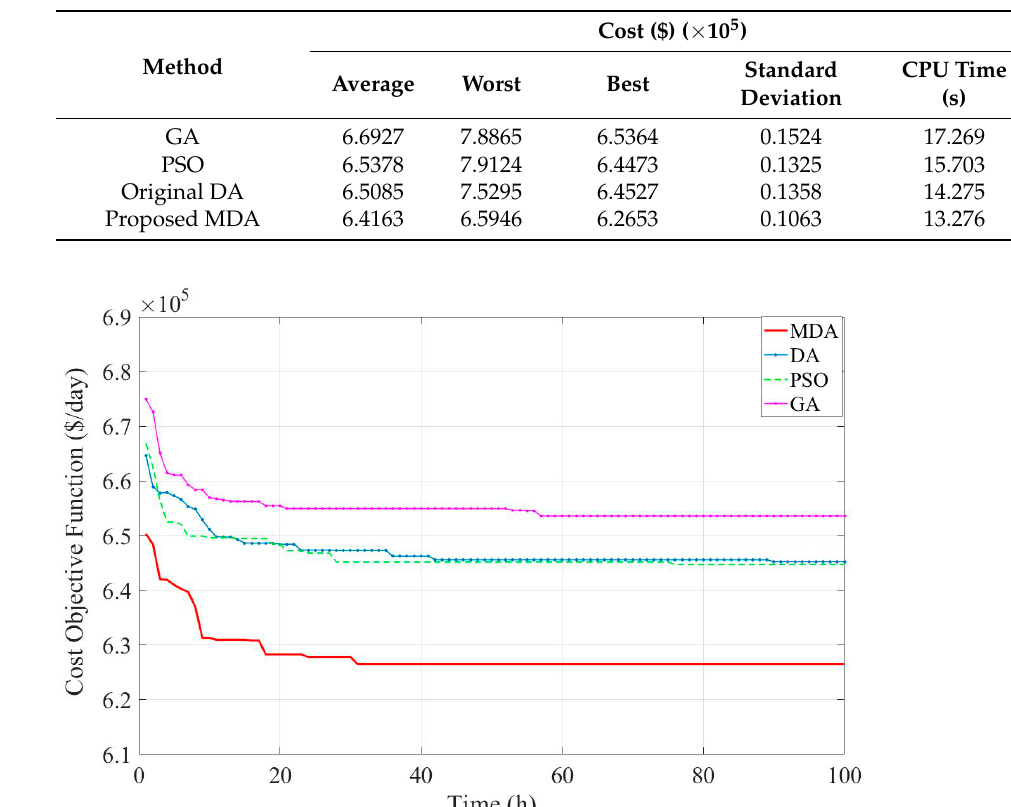
Figure 9. Comparison of the convergence curves of different optimization methods for optimizing the total cost function value. Table 8. Output power of wind units and solar panels along with the charging demands of HEVs. Wind